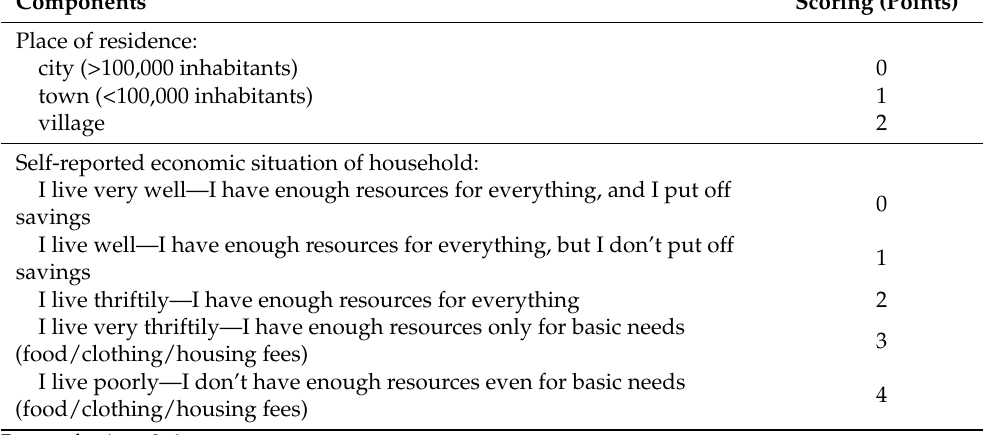
Table 1. The Socioeconomic Status Index (SESI)—components data and scoring.